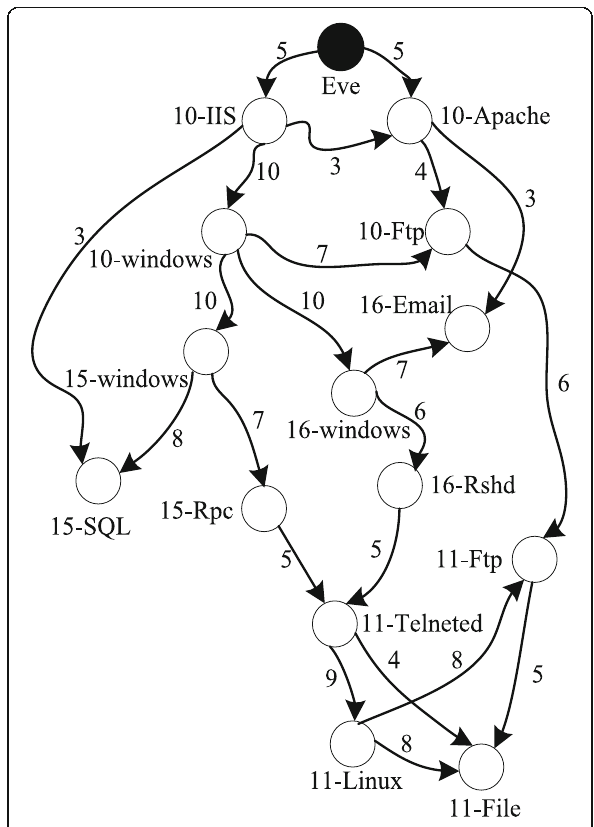
Fig. 9 Logic access modeling results of risk diffusion for experimental